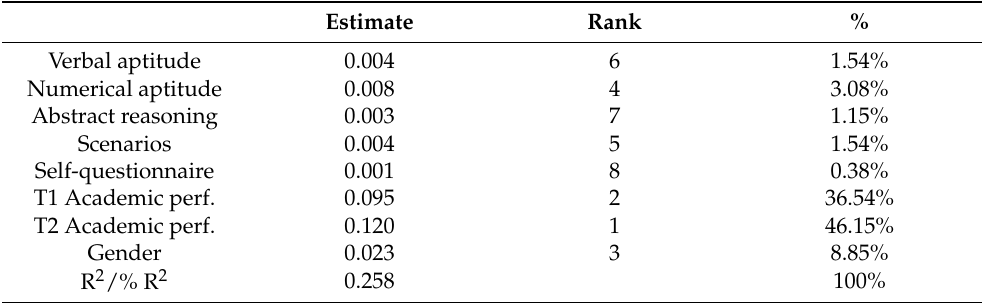
Table 4. Results of general dominance analyses for T3 academic performance in the whole